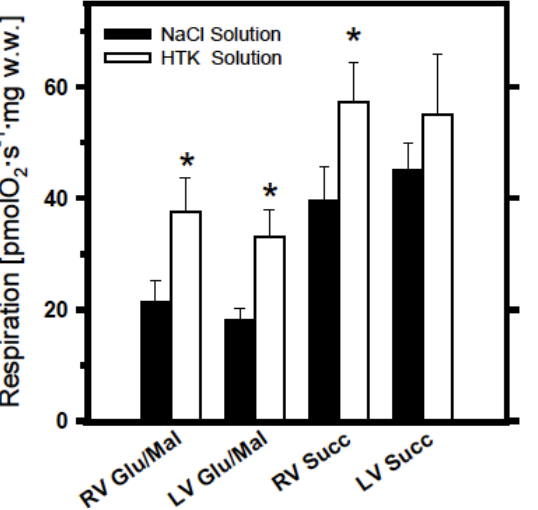
Figure 1. Respiratory activities of mitochondria in permeabilized myocardial fibers cryopreserved in liquid nitrogen using special DMSO containing preservation solution, see [2] after 14 h cold storage in either NaCl solution ( filled bars ) or in Bretschneider’s histidine-tryptophan-ketoglutarate (HTK) preservation solution ( empty bars ). Respiration was measured at 30 °C with glutamate + malate or with succinate + rotenone as described in Methods Section and expressed in pmols oxygen per second, per mg wet weight. Significantly higher respiration rates can be seen after cold ischemia in HTK solution ( * p <